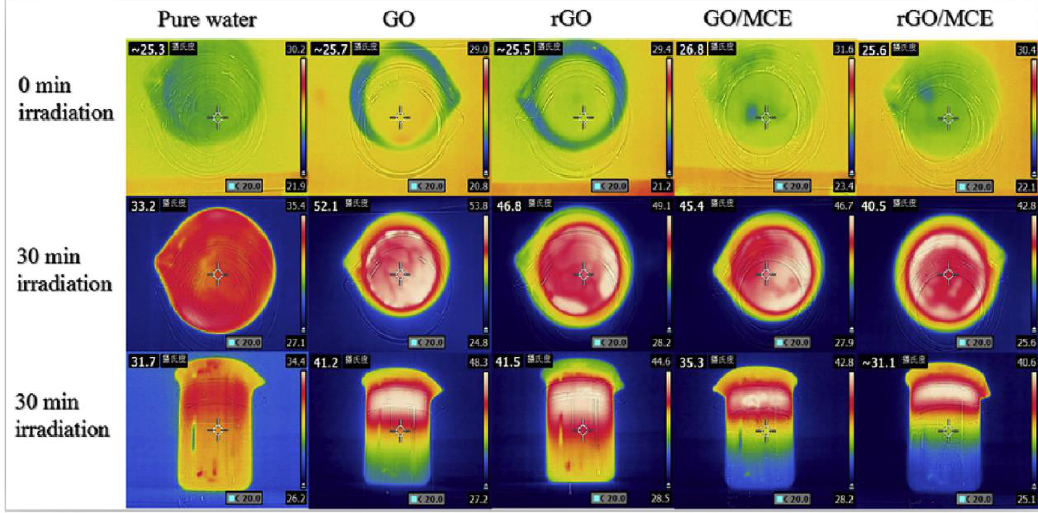
Figure 29. Surface temperatures of bulk water in different samples before and after solar illumination, and the whole water temperature distribution after illumination (IR camera) [95]; 2017, Elsevier.